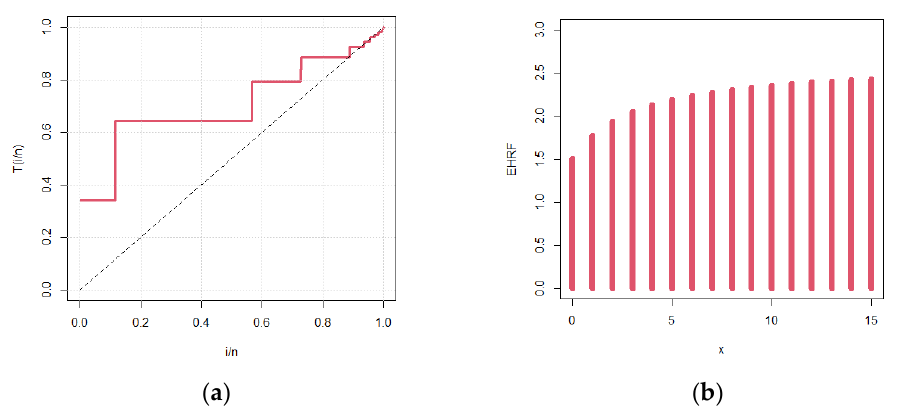
Figure 8. ( a ) TTT plot and ( b ) Expected Hazard Rate Function (EHRF) for the BDLD model for the dataset.